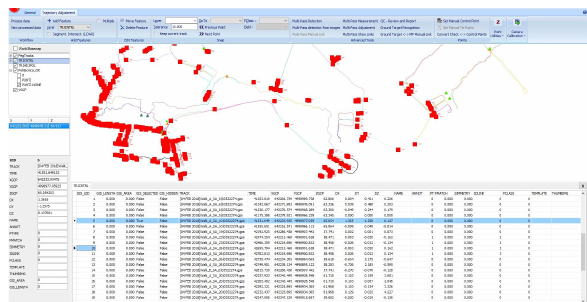
Figure 6. The map of GCPs inside Pegasus manager software after the last adjustment. The deviation is around 10-20 cm, for few unresolved areas 1 meter. Figure 7, offers a comparison of the two elaborations: on the left column, the result obtained from the first processing, only GNSS and IMU data were used; on the right column, the best statistical solution obtained with the aid of GCPs. It is evident that the separation in position (graph 2) has